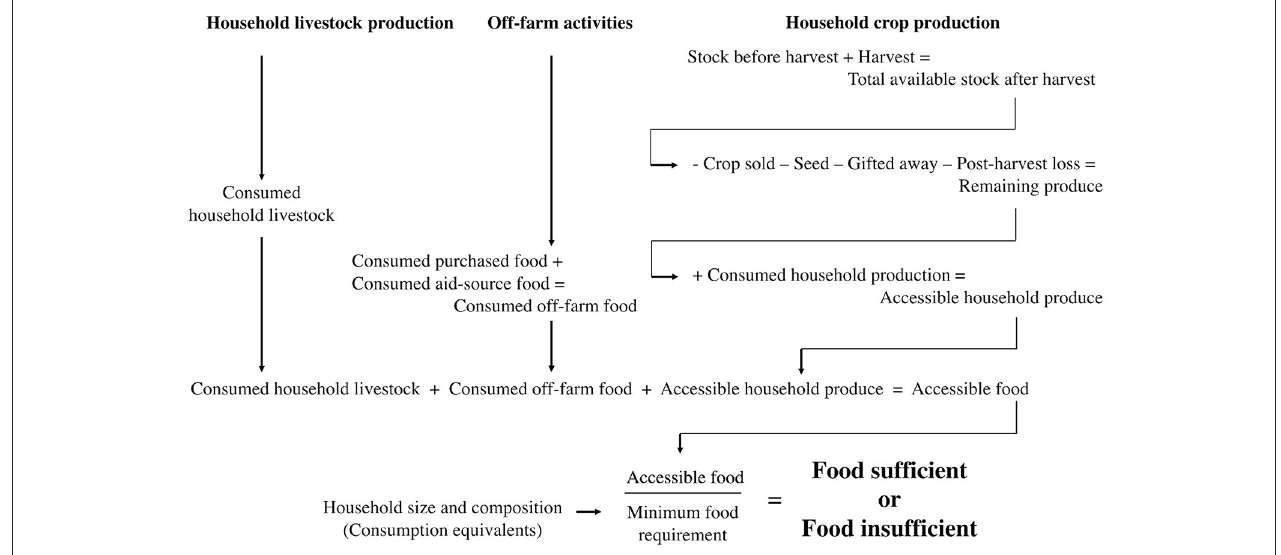
FIGURE 6 | Box plots of food sufficiency outcomes with (red) and without (grey) conservation agriculture (CA) practices across target groups in Mozambique. The food requirement threshold for energetic needs (2100 kcal/CE/day) is indicated with a horizontal line. The food requirement threshold for protein needs (60 g/CE/day) is indicated with the vertical line.